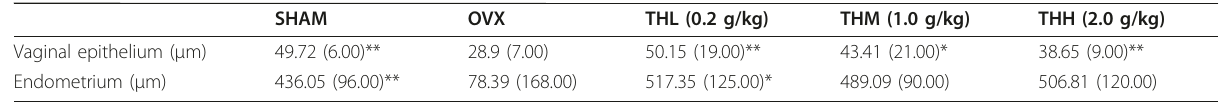
Table 2 Effects of Tualang honey on epithelial vaginal thickness and endometrial uterine thickness after 2 weeks